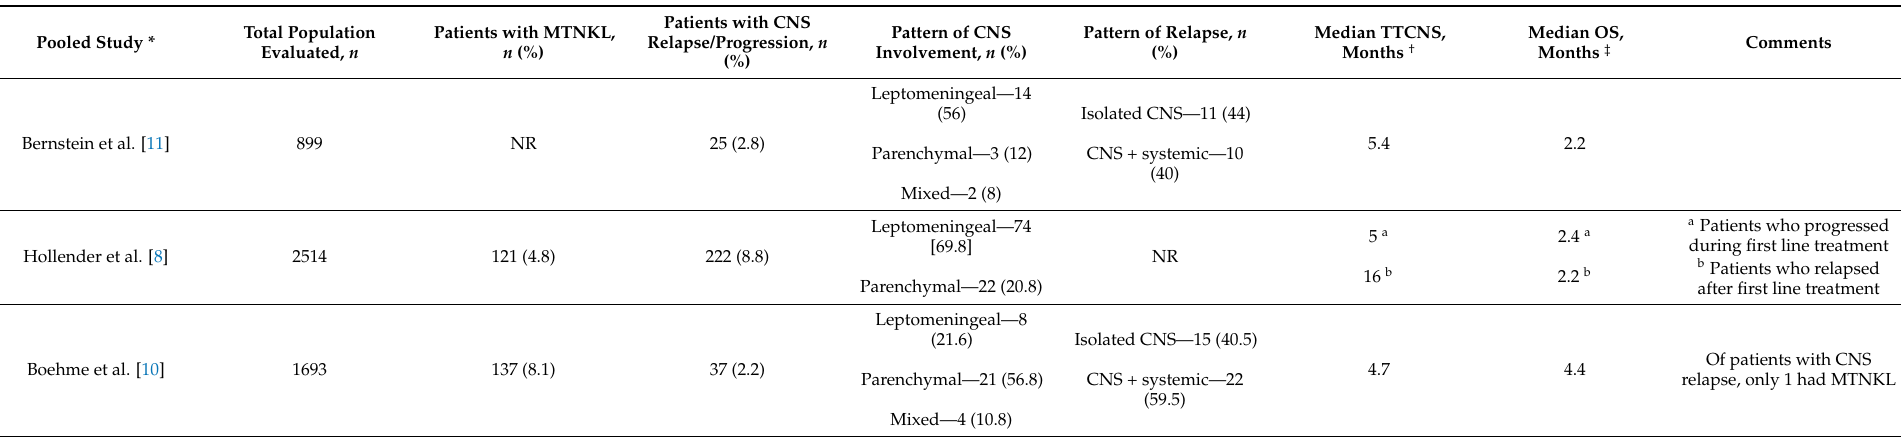
Table 1. Summary of pooled studies describing incidence, patterns, and outcomes of CNS relapse in patients with MTNKL.